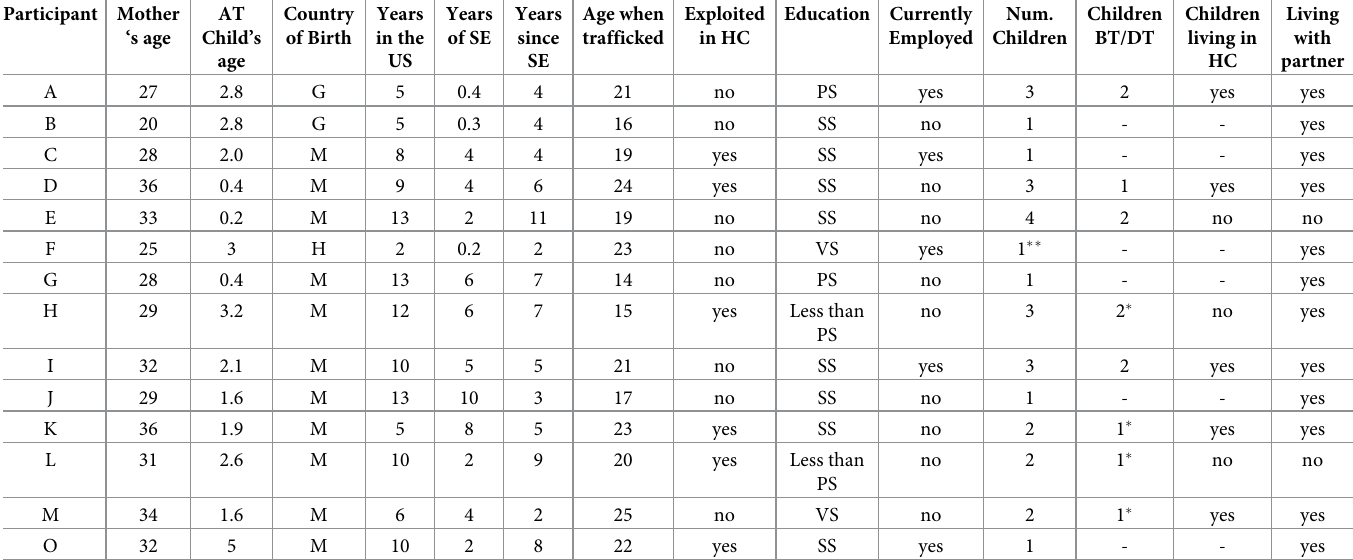
Table 2. Participant characteristics.